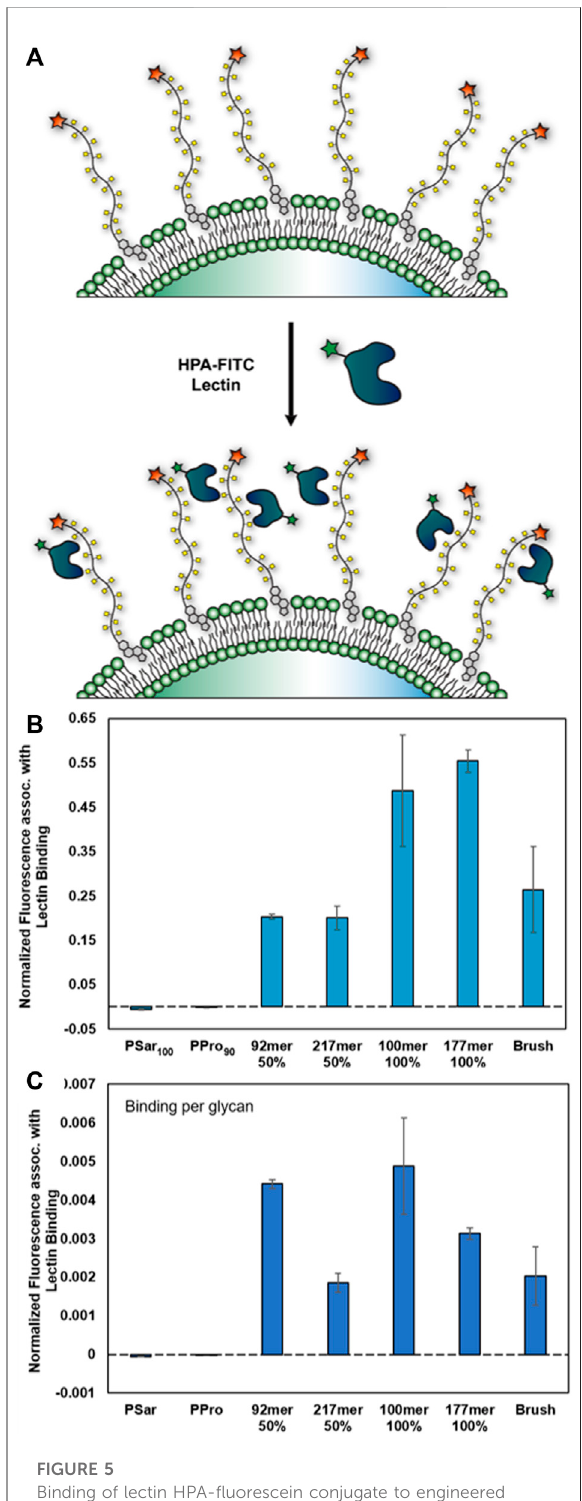
FIGURE 5 Binding of lectin HPA- fl uorescein conjugate to engineered glycocalyces of varied composition (A) Cartoon representation of α GalNAcSer binding by hexameric HPA lectin. (B,C) Data were collected in Raji cells via fl ow cytometry and are averages of medianscalculatedaftergatingforlive,singletcellsandassociated standard error, and were collected in duplicate. Data has been